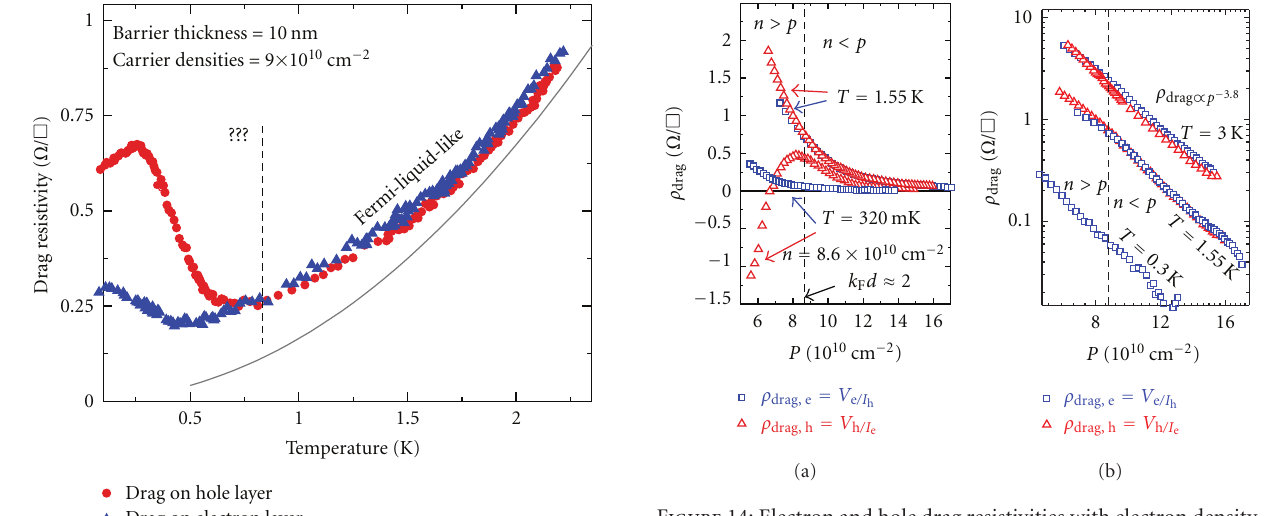
Figure 14: Electron and hole drag resistivities with electron density held constant at n = 8 . 6 × 10 10 cm − 2 versus hole density at T = 320 mK, 1.55 K, and 3 K. (Device: B138/C4-1-10nm Barrier). ( ρ drag ∝ p − 3 . 8 ). At the lowest temperature, the electron